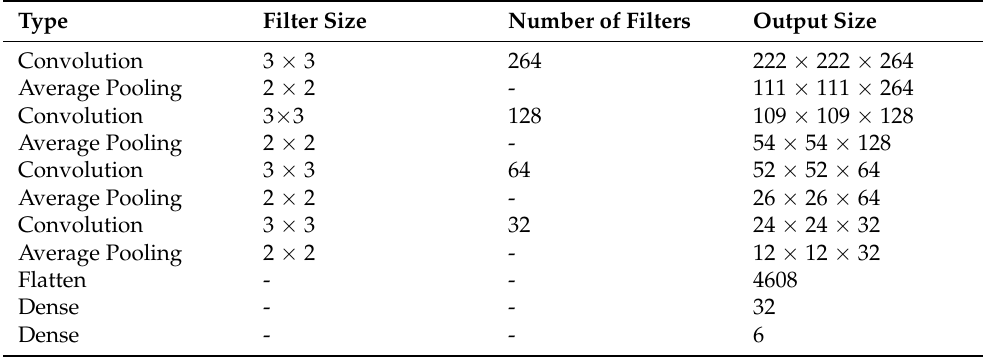
Table 1. CNN for image classification. Size of input image was 224 × 224 × 3 where 3 represents the three color channels of R(red), G(green) and B(blue)